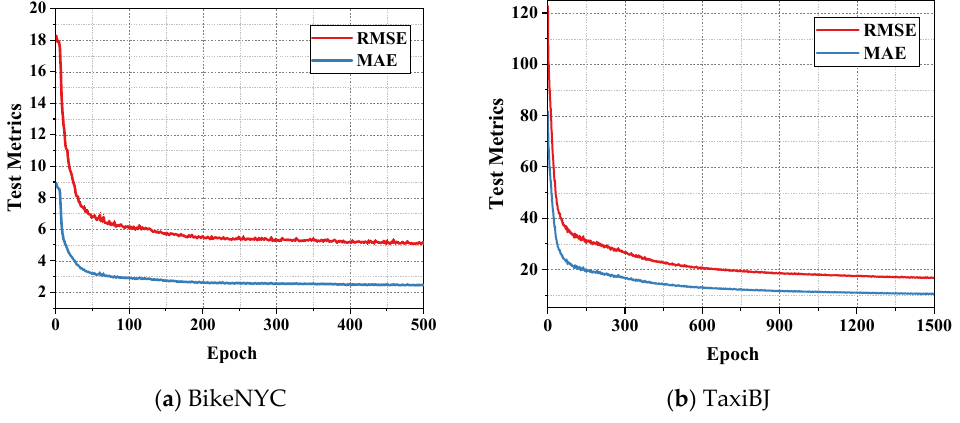
Figure 7. The testing metrics on two datasets.